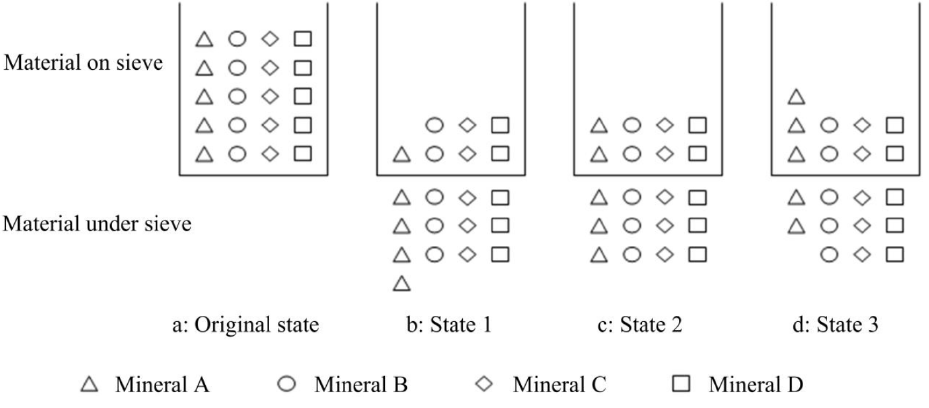
Figure 1. The grinding of mineral